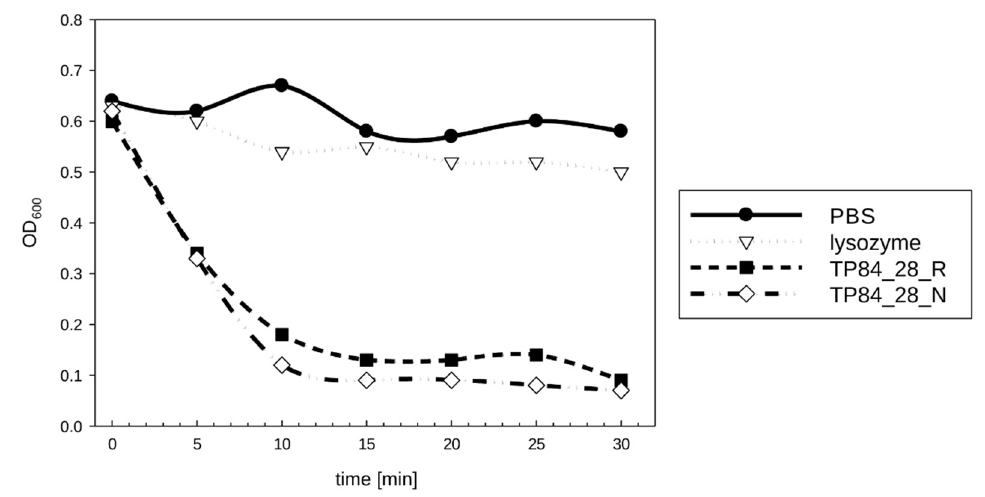
Figure 3. Comparison of the enzymatic activity of native and recombinant TP84_28 endolysin on G. stearothermophilus strain 10. Chicken egg lysozyme and PBS buffer were used as controls. The reaction was conducted at 55 ◦ C for 30 min, an optimal temperature for TP84_28 endolysin. Thus, chicken egg lysozyme exhibits only traces of activity. TP84_28_N—native TP84_28 endolysin; TP84_28_R—recombinant TP84_28 endolysin.